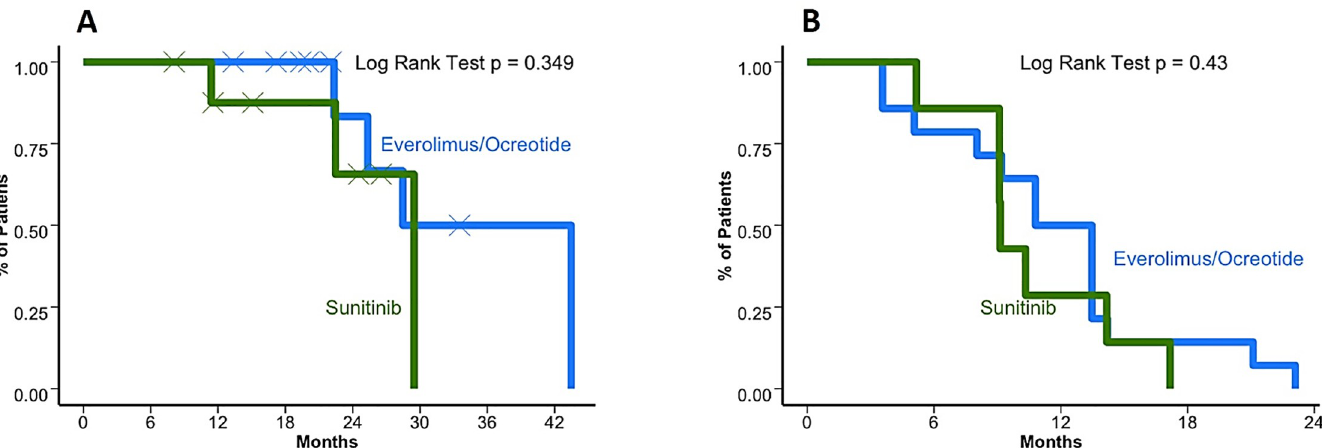
Fig 2. Overall survival and progression free survival for first-line Everolimus+octreotide and sunitinib (A) Kaplan–Meier curve for first line overall survival (OS). Everolimus ± octreotide and sunitinib offered a median of 36 months (95%CI 25.3–41.7) and 29.5 months (95%CI 22.5–37.5; p = 0.349), respectively. (B) Kaplan–Meier curve for first line progression free survival (PFS). Everolimus ± octreotide and sunitinib offered a median of 12.1 months (95%CI 9.2–21.1) and 9.1 months (95%CI 6.8– 16.8; p = 0.43), respectively.